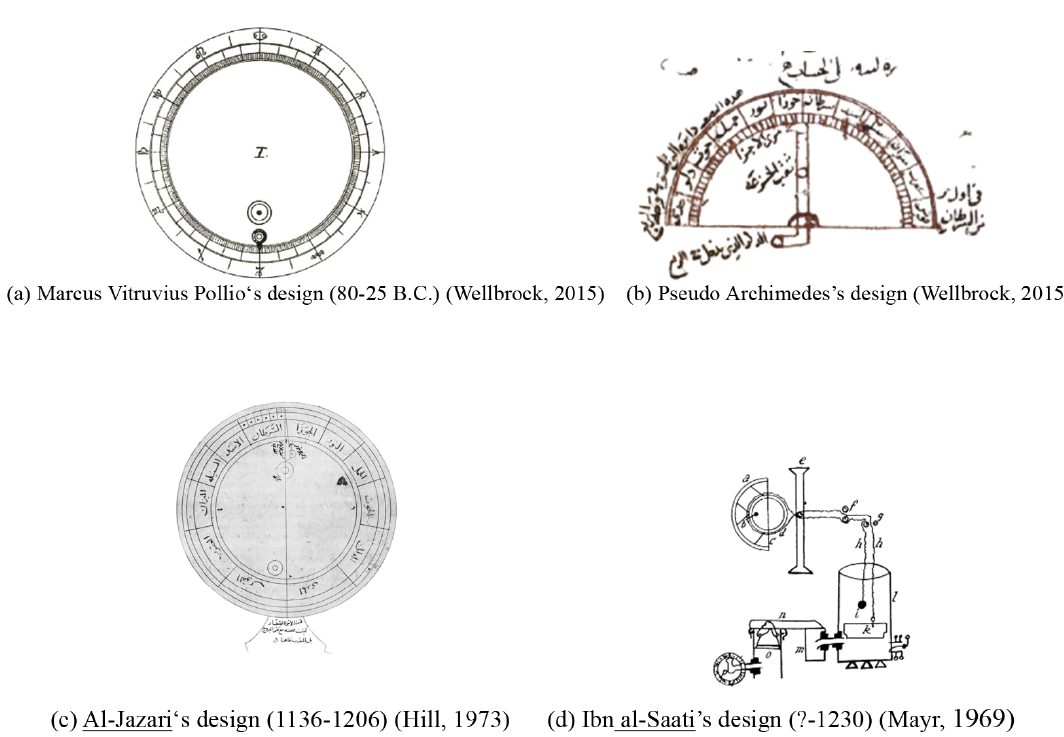
Figure 4. The Western designs of flow control